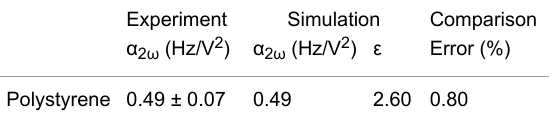
EFM cross-sectional profiles (Figure 7b,d). The average value of both profiles around the sample center was also calculated.